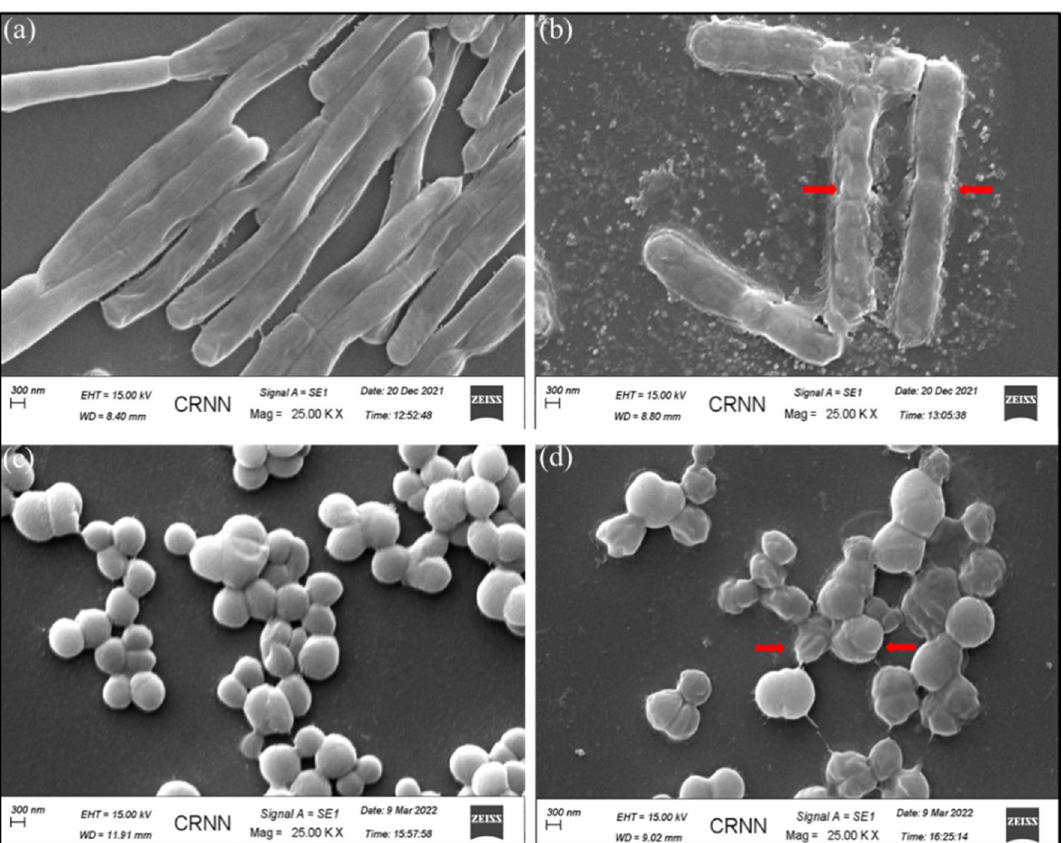
Figure 4. Pyrimidomycin induced membrane disruption of the test organisms B. cereus MTCC 1272 ( a , b ) and S. aureus MTCC 96 ( c , d ). ( a , c ) SEM images of untreated bacteria with smooth surface; ( b , d ) images showing cell compartment disruption (arrow-heads) visualized when the cells were treated with pyrimidomycin.